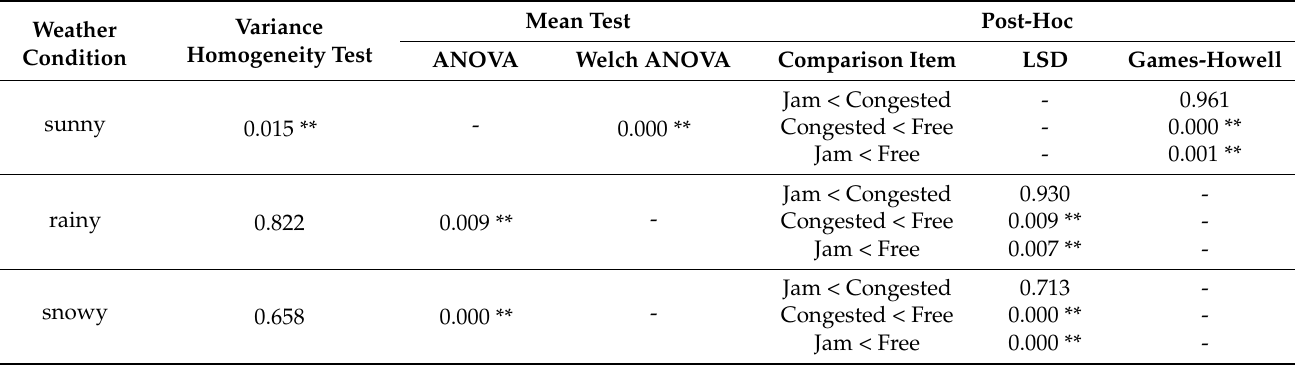
Table 13. Significance test of the influence of traffic flow on “time to half speed”.